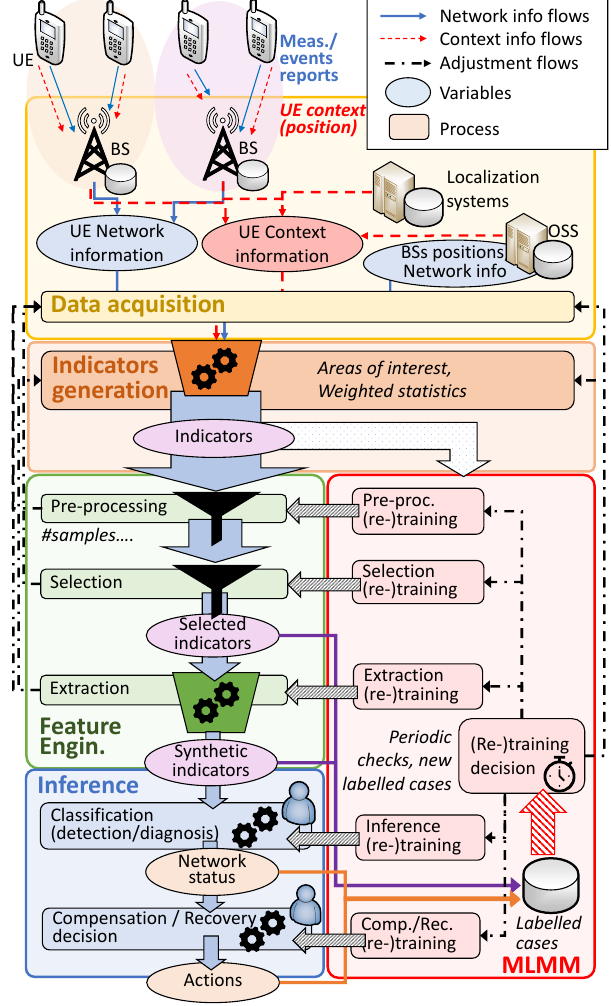
Figure 2. Proposed system